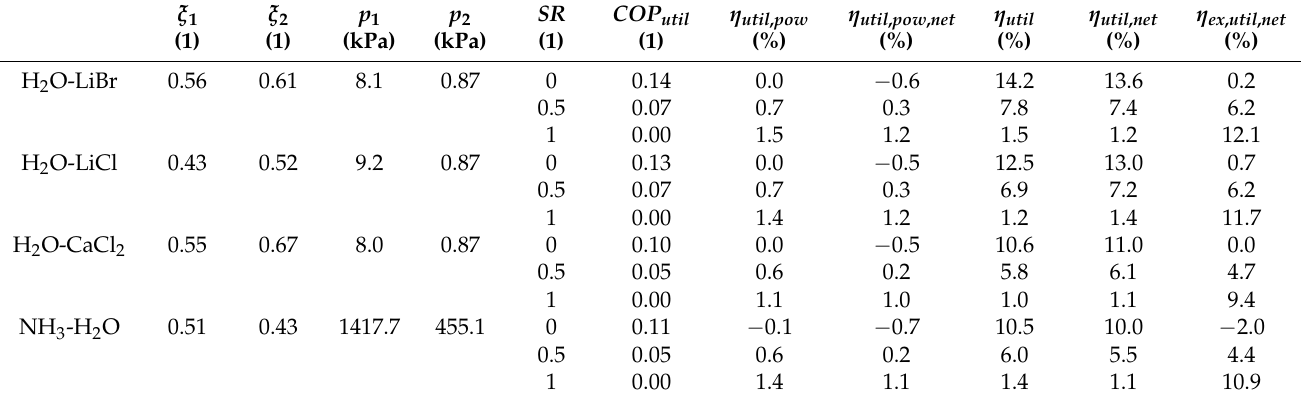
Table 4 lists the results of the heat source utilisation parameters. The pressures and concentrations were optimised in the same way as described in the previous section. There was a small difference in the cycle parameters, regardless of the optimisation for heat source utilisation. This is discussed in the Section 3.5. The LiCl and LiBr solutions again exhibited the best chiller performance, followed by the water–ammonia and CaCl 2 solutions. The LiBr and LiCl solutions also provided the highest power production efficiency. The best performance of these two salts was also observed in the exergy efficiency of heat source utilisation. The NH 3 –H 2 O mixture again proved to have the lowest chiller performance (even negative exergy efficiency) with the highest power requirement and lowest COP. However, in power production, it surpasses the CaCl 2 solution. Table 4. Main resulting utilisation parameters of the different working fluids: salt solutions and water–ammonia mixture. ξ 1 ξ 2 (1)